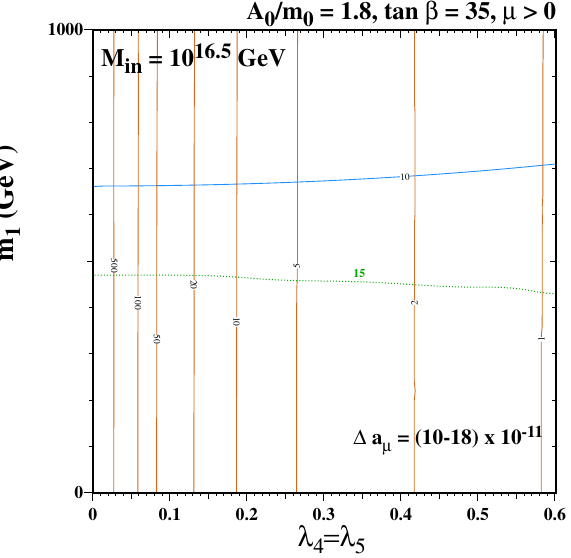
= 1 TeV, while in the right panel M = 2 . 4 TeV, M = 0 . 2 TeV, m ¯ X 1 5 5 = 0 . 5 TeV. The contours are as in Fig. m 10 = 1 TeV and m ¯ 5